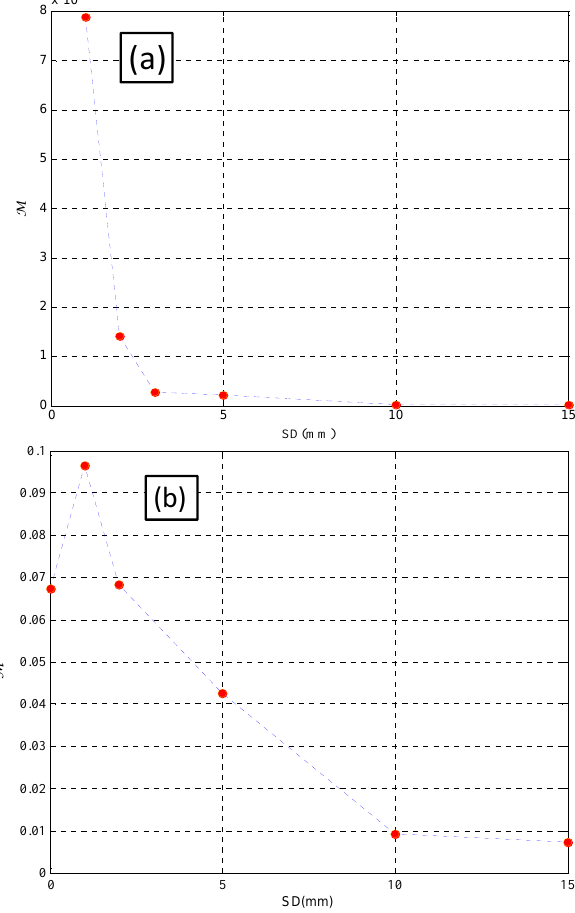
Figure 8. Convergence of the synchronization criterion (M) over 100 realizations (for each Shear Displacement –SD (mm)) of diffusion based networks equation on a) perpendicular and b) parallel aperture networks. The number of nodes in the model for all of the cases is decreases to 250 nodes (1:4 scaling).